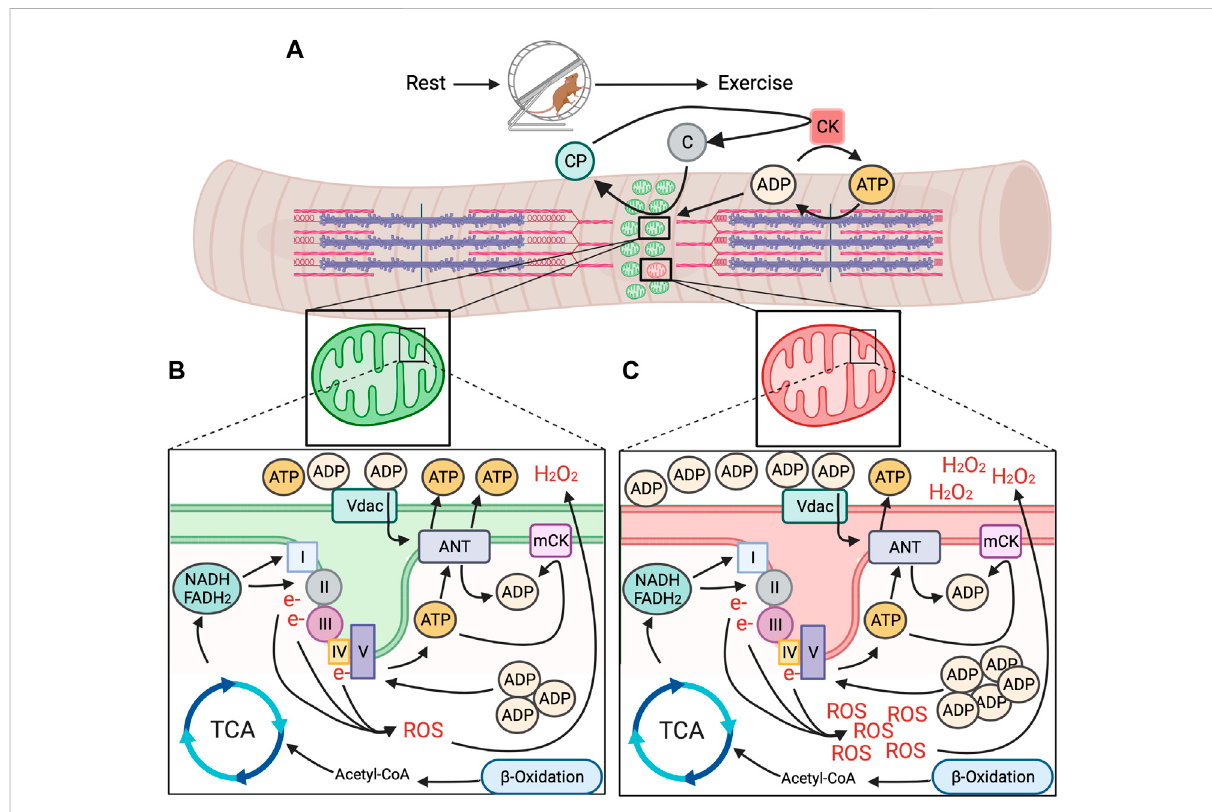
FIGURE 1 Model for mitochondrial energetic stress in skeletal muscle with exercise between healthy and unhealthy regions of the mitochondrial reticulum. (A) .RepeatedmusclecontractionwithprolongedexerciserequiressustainedhydrolysisofATPanddonationofphosphatesfromcreatine phosphate (CP), creating free creatine that is turned back to CP by mitochondrial creatine kinase (mCK) through the donation of a phosphate from intramitochondrialATP. (B) .Inhealthyregionsofthemitochondrialreticulum,accumulationofintramitochondrialADPpromotesgenerationof ATP from nutrient substrates via TCA cycle and ß -oxidation and through the ETC to meet energy demand, without undue accumulation in function altering intermediates (e.g.,ROS). (C) . Inspatially distinctunhealthy regions ofthemitochondrialreticulum,ATP production does notkeep pace with energetic demand, resulting in accumulation of intra and extramitochondrial ADP and excessive generation of ROS, potentially acting as energetic signals for removal via